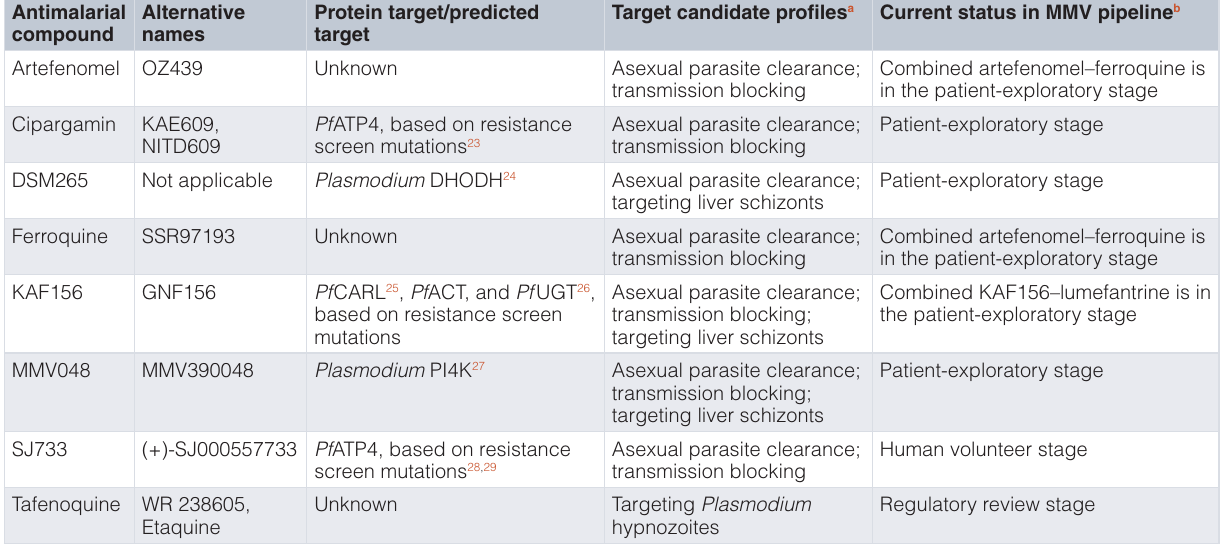
Table 1. Selected promising antimalarial